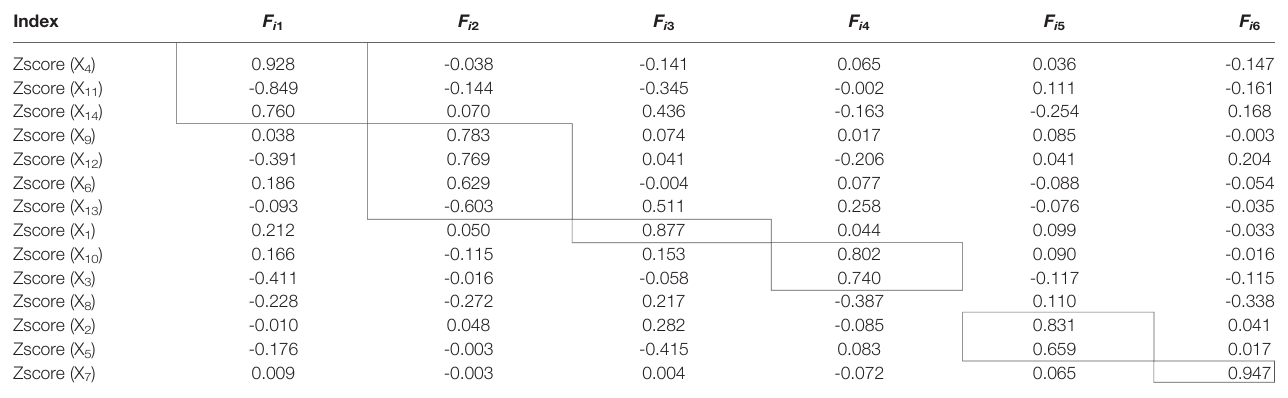
TABLE 5 | Component matrix of